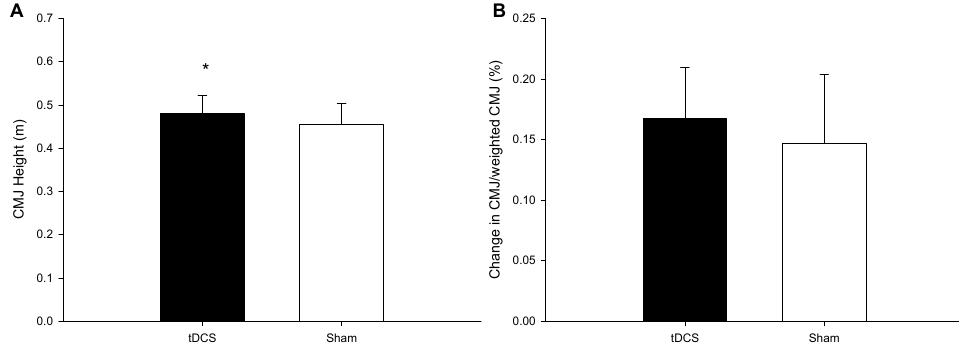
Figure 2. Countermovement jump height, and ( A ) the change in CMJ/weighted CMJ ( B ). * mean a significantly different between tDCS group and Sham groups. Values are mean ± SD.